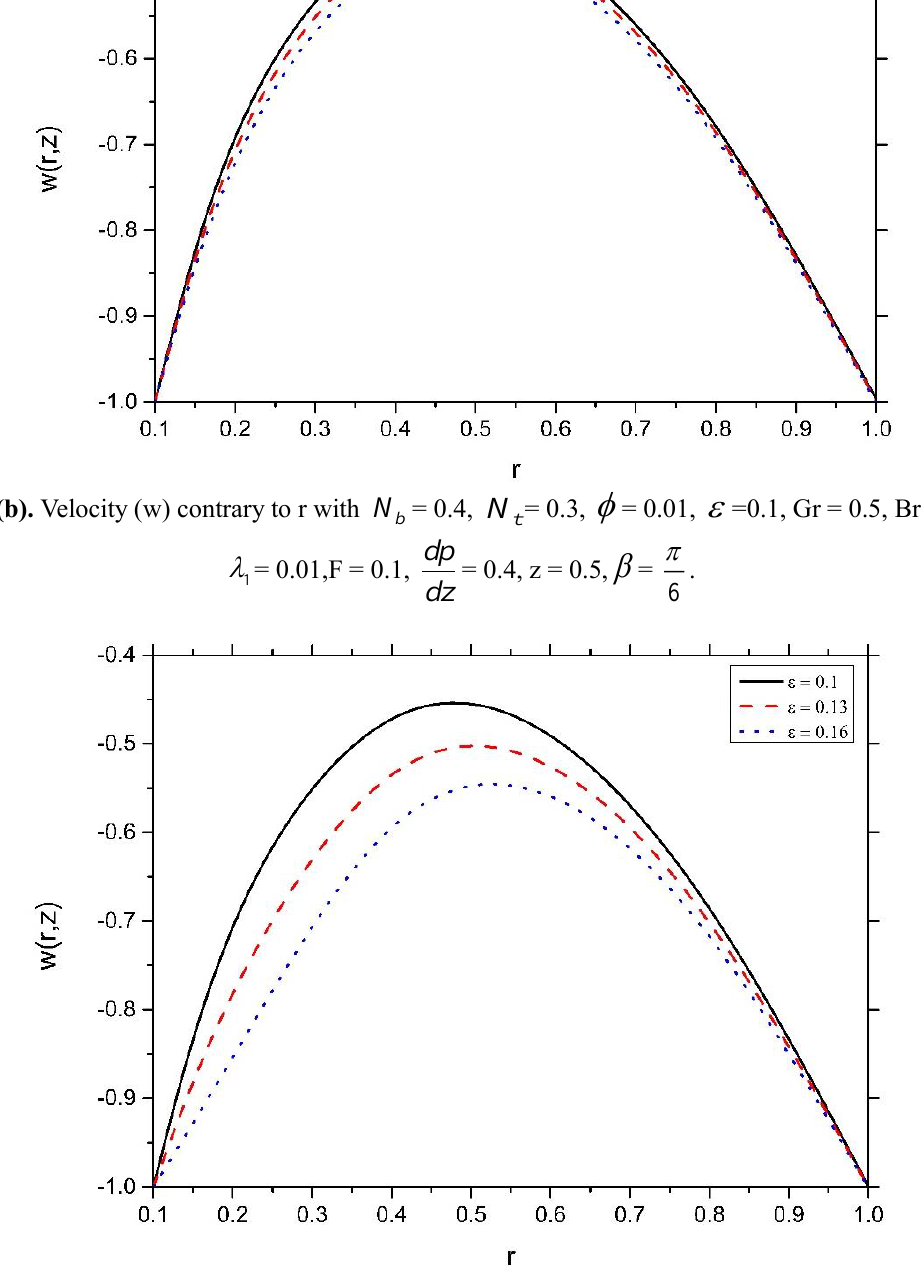
N = 0.4, N = 0.3,  = 0.01, Gr = 0.5, Br = 0.3, b t dp dz = 0.4, z = 0.5,  =